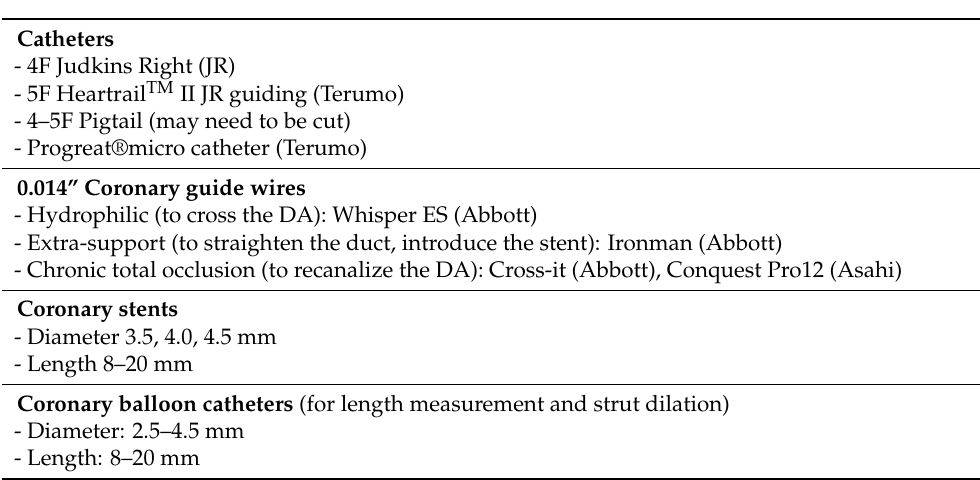
Table 1. Instruments for ductal